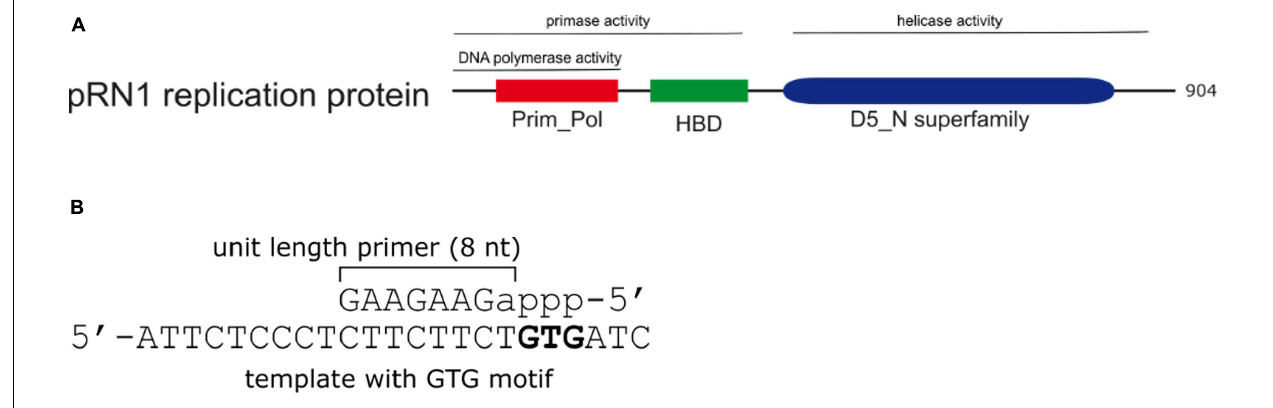
FIGURE 1 | Domain structure and primer product of the pRN1 replication protein. (A) Domain structure and activities of the pRN1 replication enzyme. The pRN1 primase consists of an N-terminal catalytic domain (Prim_Pol, cd04859 amino acids 40–248, red), a flexible linker (amino acids 249–260) and a C-terminal helix bundle domain (HBD, pfam13010 amino acids 256–370, green). The full-length replication protein also contains a C-terminal helicase domain (blue) which is independent to the primase domain (Beck and Lipps, 2007). This study was performed with deletion mutants comprising the Prim_Pol, linker, and HBD. (B) The enzyme synthesizes an 8 nt long mixed RNA/DNA primer. Ribonucleotides are in lower case, deoxyribonucleotides in capitals. The primase requires a GTG recognition motif in the template, downstream of which the primer is formed.